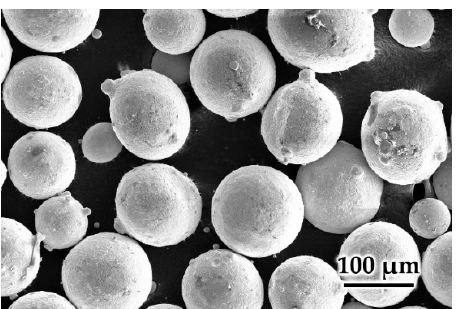
Figure 1. Circular backscatter detector (CBS)-SEM image of the starting powder of supplied Hastelloy C-22. Table 1. Composition of Hastelloy C-22.